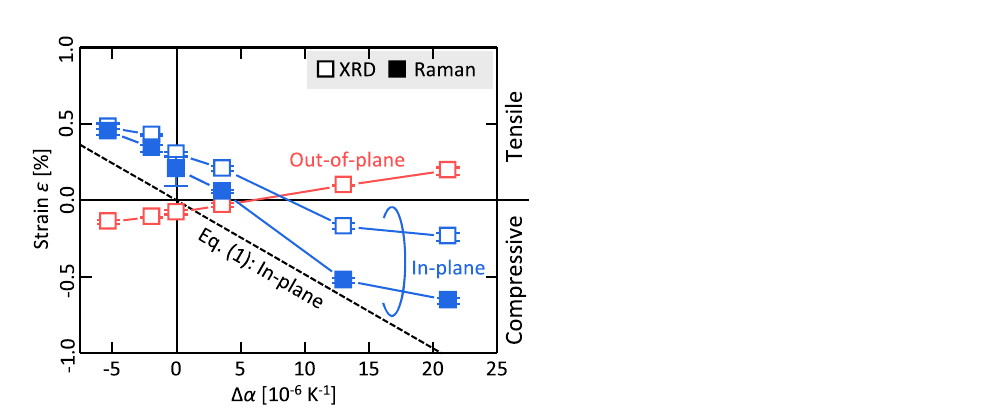
Figure 3. In-plane and out-of-plane strains ε of the Ge layer as functions of Δ α . The experimental data were derived from the Raman (closed squares) and XRD (open squares) measurements. The theoretical data for the in-plane direction derived from Eq. (1) are shown by the dotted line. The error bars indicate the variability in the Raman and XRD measurements for each